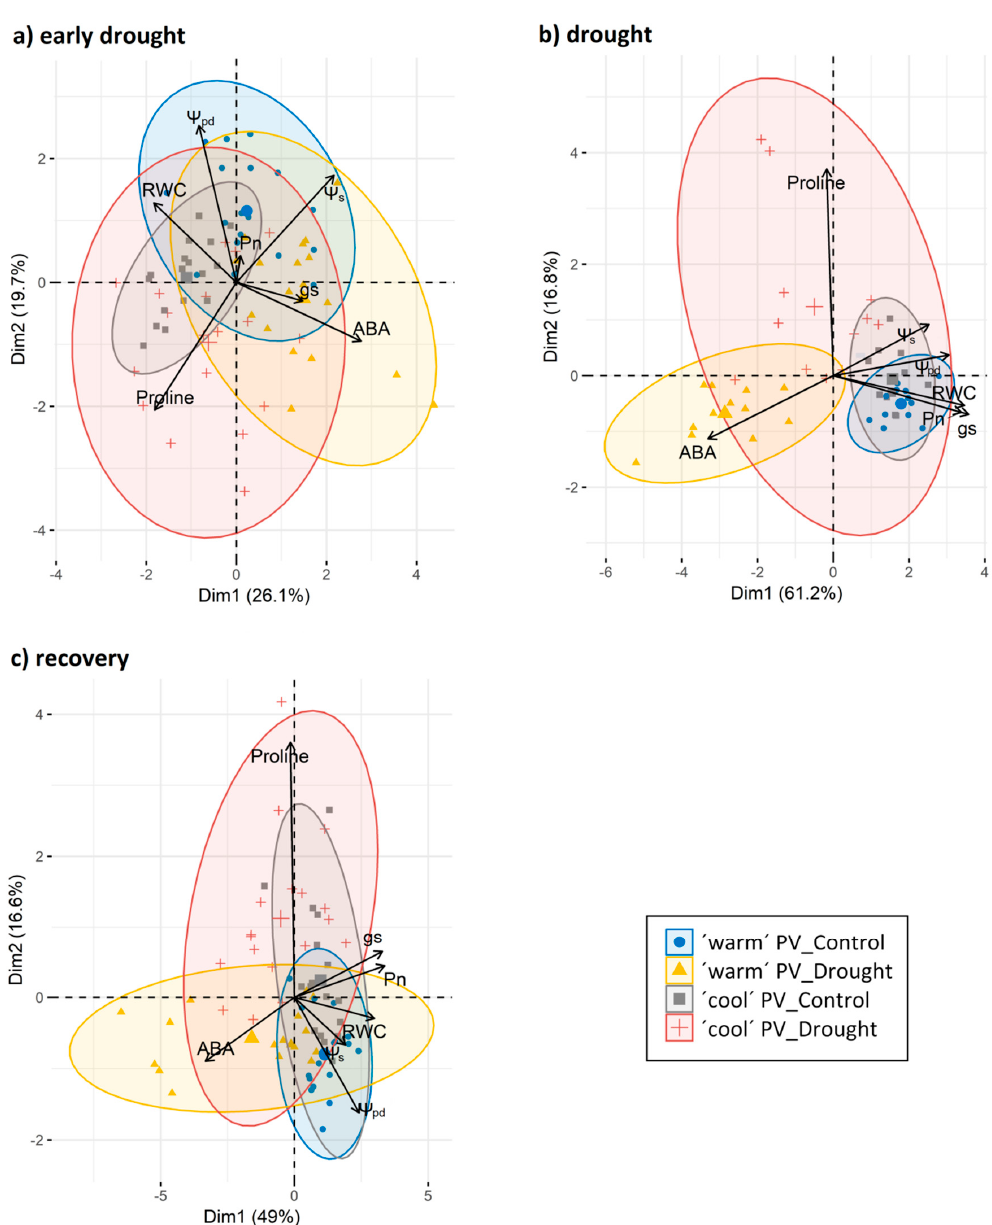
Figure 4. Principal component analyses for ( a ) early-drought conditions, ( b ) drought, and ( c ) the recovery period. The ellipses represent 95% confidence intervals around the centroid (bigger symbol) of each data cluster. The percentage on the axes indicates the proportion of the variance that is explained by the given principal component.